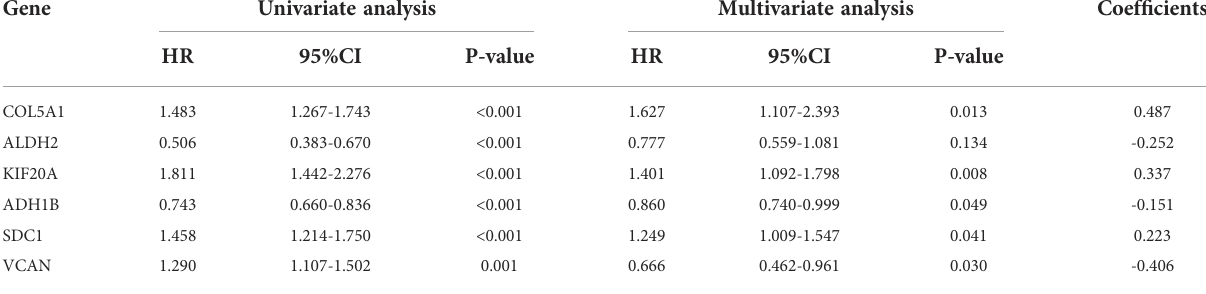
TABLE 2 Characteristics of genes in the prognostic model.